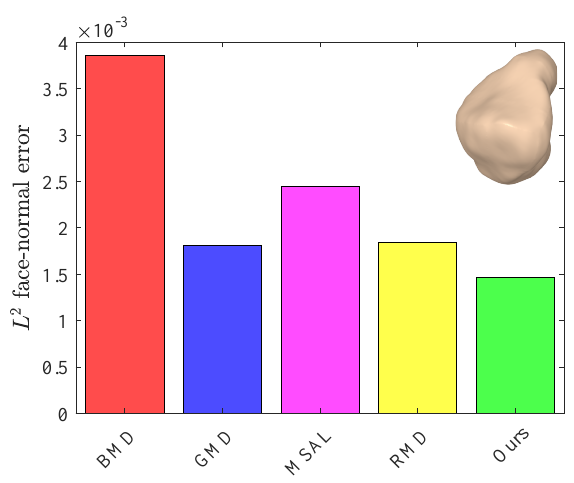
Figure 13. L 2 face-normal errors for the left hamate model.